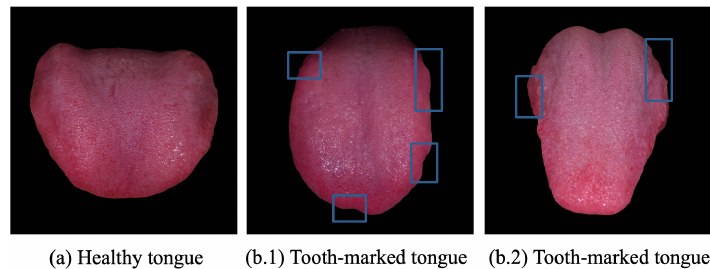
Figure 1. Examples of a heathy tongue and tooth-marked tongues. The tooth-marked regions in (b.1) are obvious, while the tooth-marked regions on (b.2) are difficult to